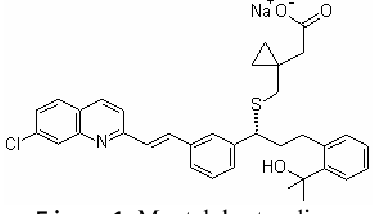
Figure 1. Montelukast